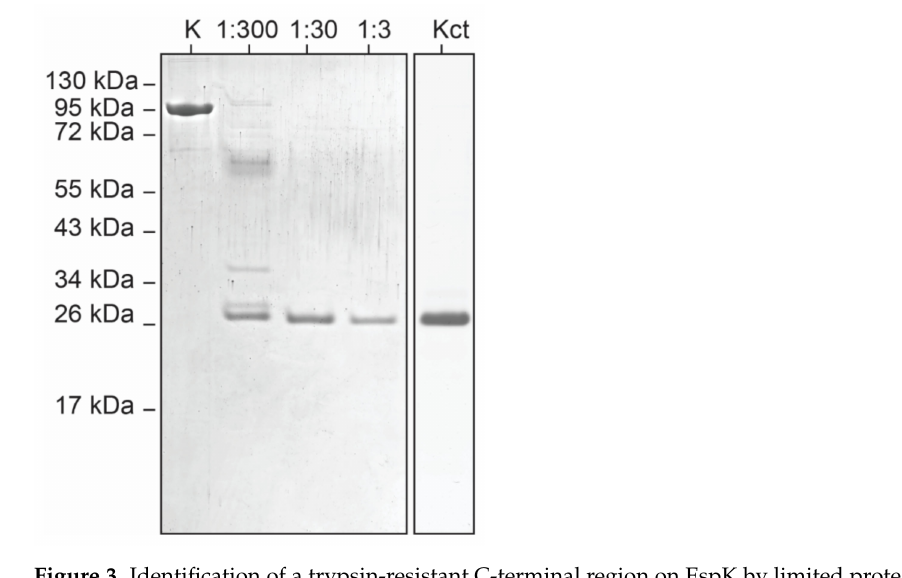
Figure 3. Identification of a trypsin-resistant C-terminal region on EspK by limited proteolysis. First lane (K)—full-length EspK, lanes 2–4: EspK digestion using different molar ratios of trypsin, lane 5: trypsin-resistant EspK fragment recombinantly